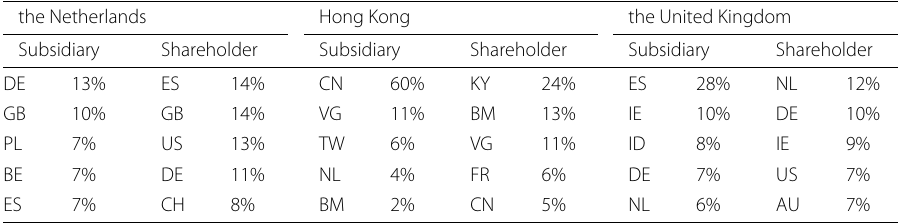
Table 5 Direct shareholders and subsidiaries of the “conduit” companies the Netherlands Hong Kong the United